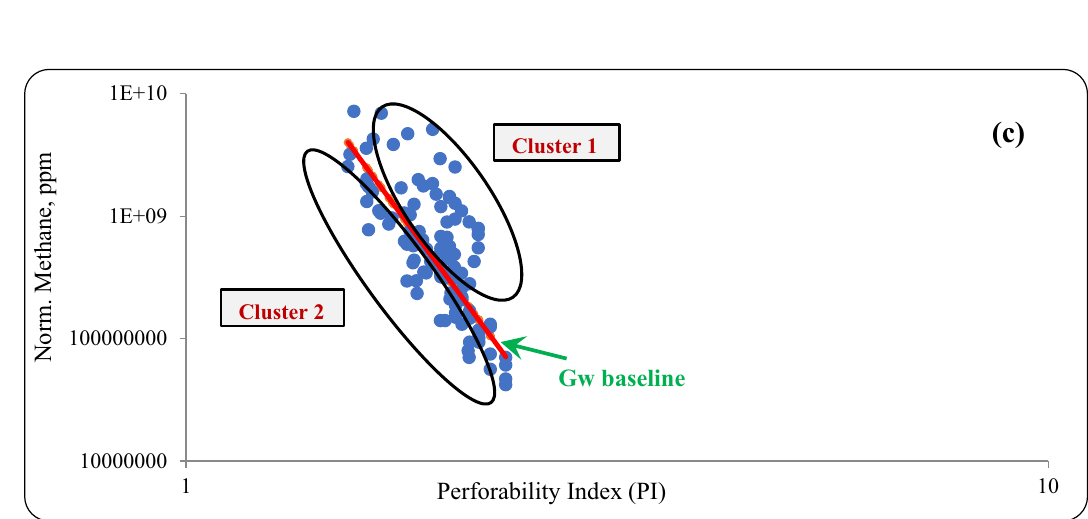
Fig. 8 Perforability index (PI) and normalized methane (ppm) relationships. a Ashrafi_H_1X_ST2, b Ashrafi_I_1X_ ST, and c Ashrafi_K_1X. Gw is the gas–water